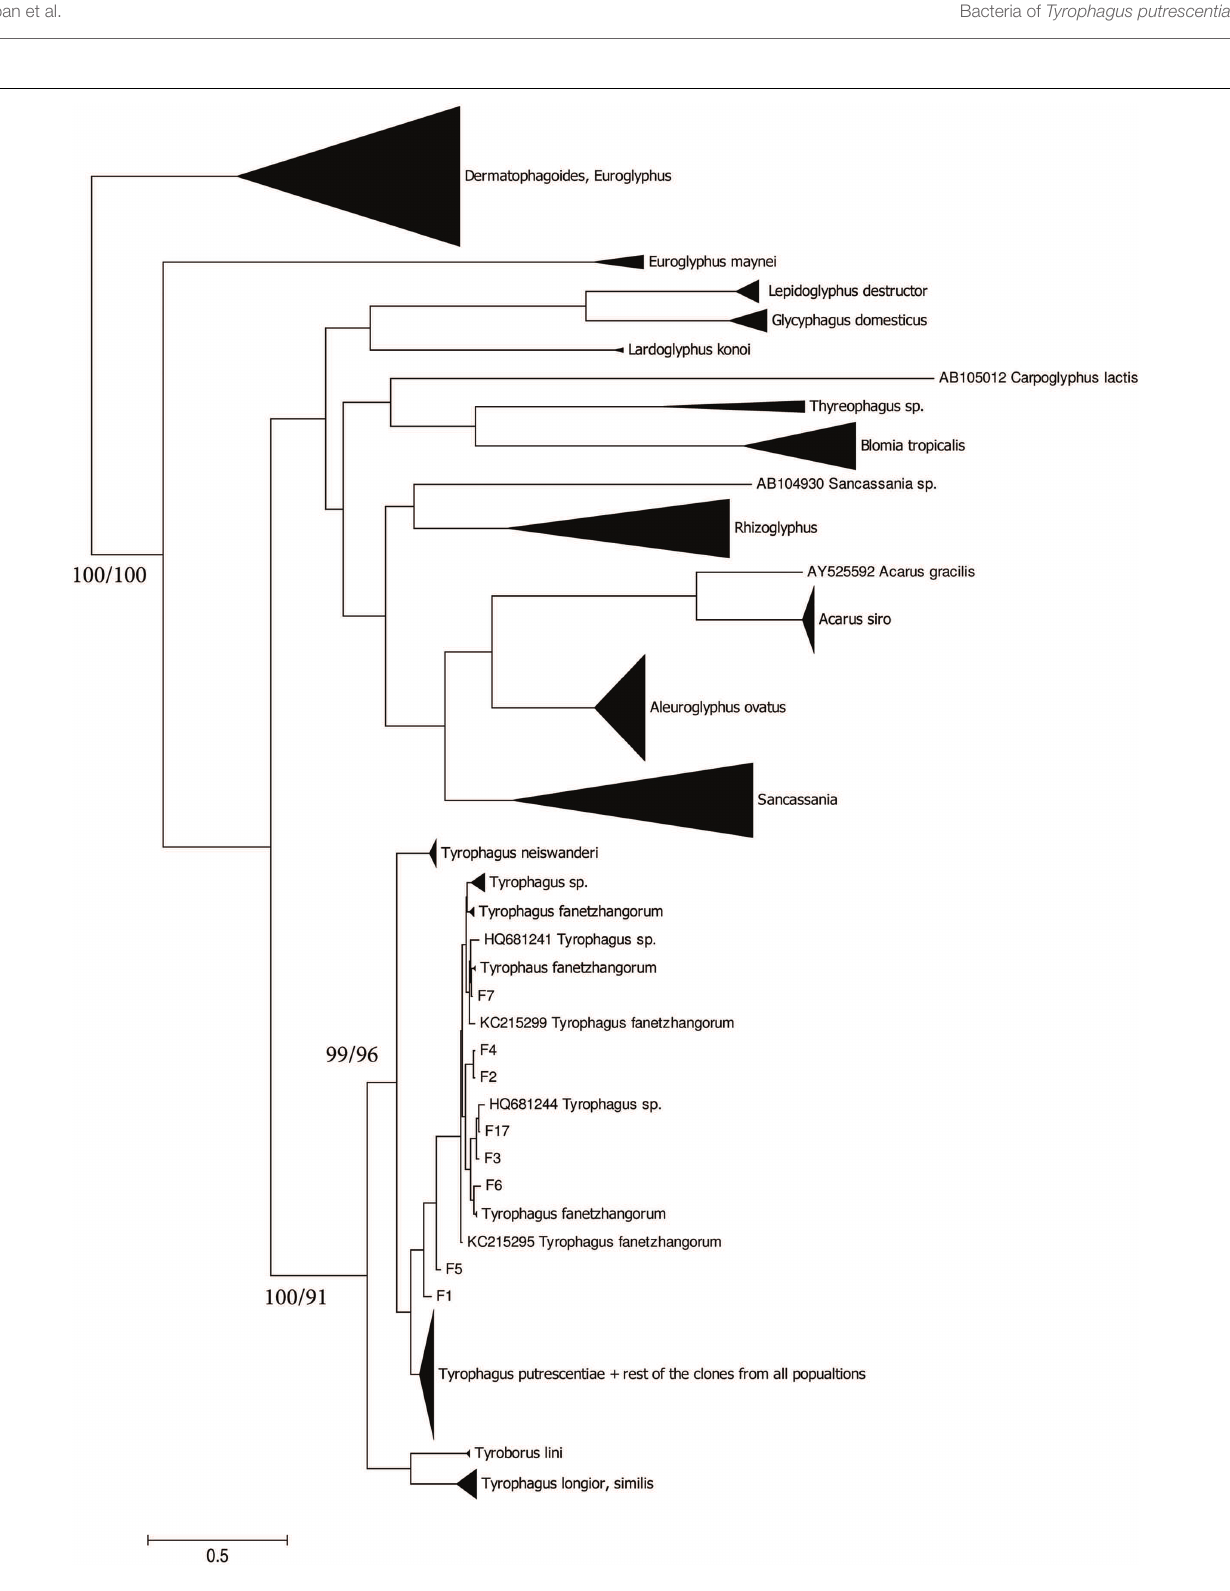
FIGURE 2 | Phylogenetic analysis of ITS clones of T. putrescentiae with the reference sequences from other related astigmatid mites (Noge et al., 2005; Liu et al., 2006; Klimov and OConnor, 2008, 2013; Yang et al., 2011; Beroiz et al., 2014). The phylogeny was inferred by Bayesian analysis of 46 partial ITS gene sequences from the observed populations, i.e., L, laboratory; K, Koppert; P, Phillips; D, Dog; H, Ham; and Z, field Zvoleneves. Branch lengths correspond to the mean posterior estimates of evolutionary distances (scale bar: 0.1). Branch labels indicate Bayesian posterior probabilities and supporting bootstrap values from maximum likelihood